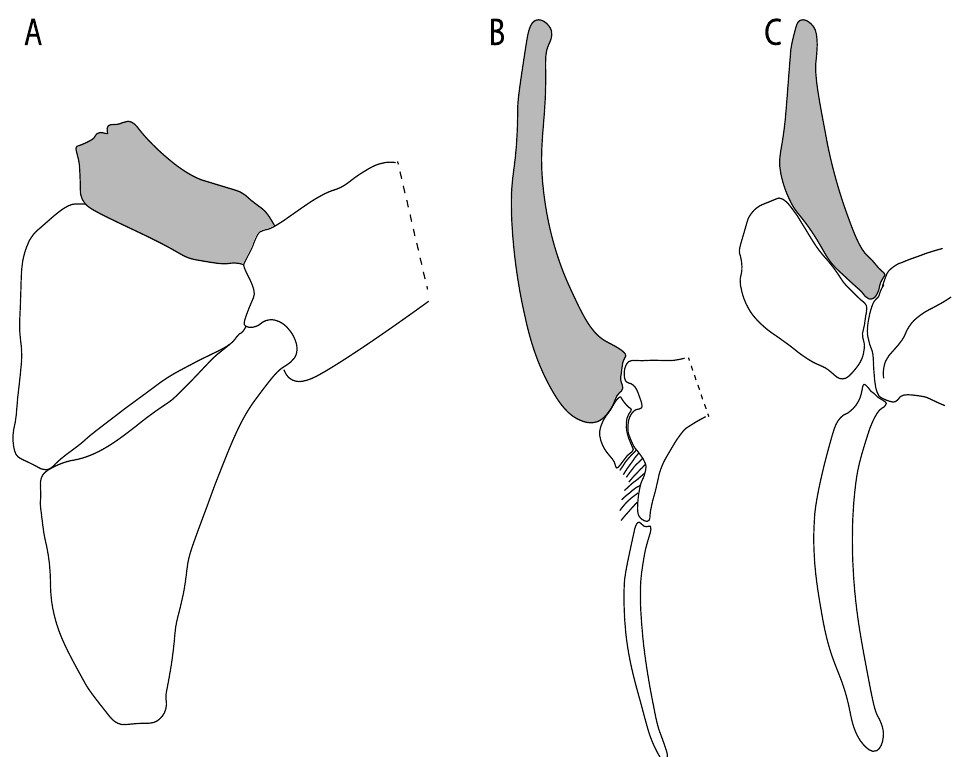
Figure 43. Interpretative drawings of the basal pectoral elements in dorsal view. State (0) ( A ) Squatina guggenheim (MZUSP 110871) redrawn and modified from da Silva and de Carvalho Text-Figure 12G in [8]. State (1) ( B ) Glaucostegus granulatus (NHMUK 2012.2.8.54); ( C ) † Asterodermus platypterus (NHMUK PV P 10934). Propterygium colored in gray. 108. First segment of propterygium (if propterygium extends anteriorly) : (0) Not reach- ing the nasal capsules; (1) reaches the level of nasal capsules; (2) extending well be- yond the nasal capsules. This character recovers the variation of the placement of the first propterygial segment with respect to the nasal capsules of Aschliman et al. [7] (char. 62 and 63).